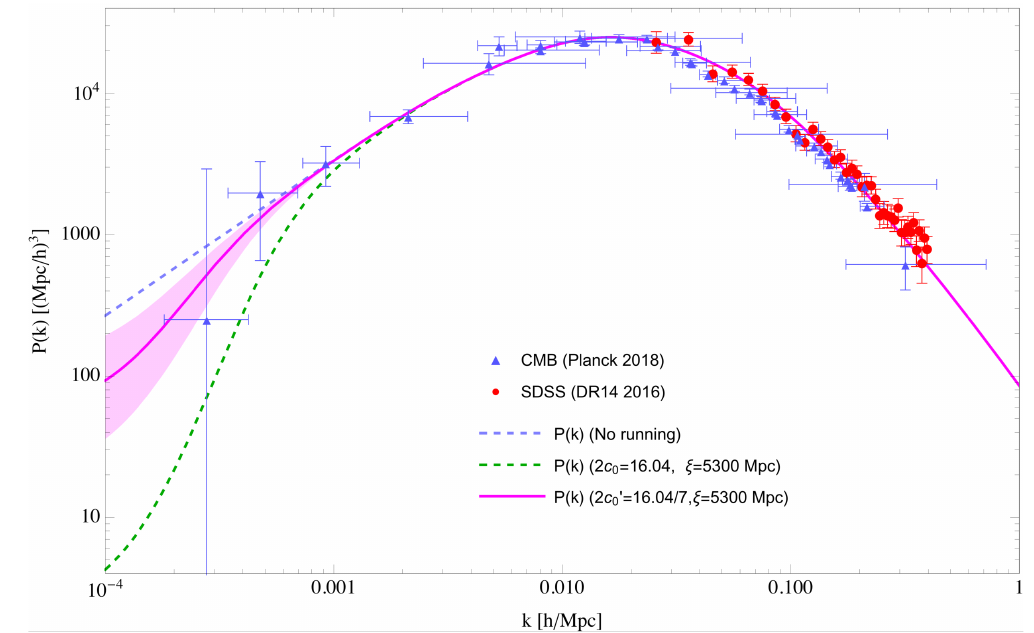
Figure 4. Matter power spectrum P ( k ) shown for various choices of the quantum amplitude c 0 . The middle (purple) solid curve shows a best fit through the last few low-k data points via an RG running of Newton’s constant G , with an amplitude of running 2 c 0 ≈ 16.04/7 ≈ 2.29, i.e., around 15% of the preliminary value of 16.04 from the lattice. The shaded (purple) band represents a variance in 2 c 0 ≈ 2.29 by a factor of 2 and 1/2. The original spectrum with no running (top, blue, dashed) and the spectrum with running of Newton’s constant G , with the original coefficient of 2 c 0 ≈ 16.04, (bottom, green, dashed) are also shown for reference. Note that the middle (purple) curve with 2 c 0 modified to 16.04/7 can also be mimicked by instead tuning the nonperturbative scale ξ to ∼ 2.5 × 5300Mpc ( ≈ 13,000Mpc) and keeping the quantum amplitude 2 c 0 =